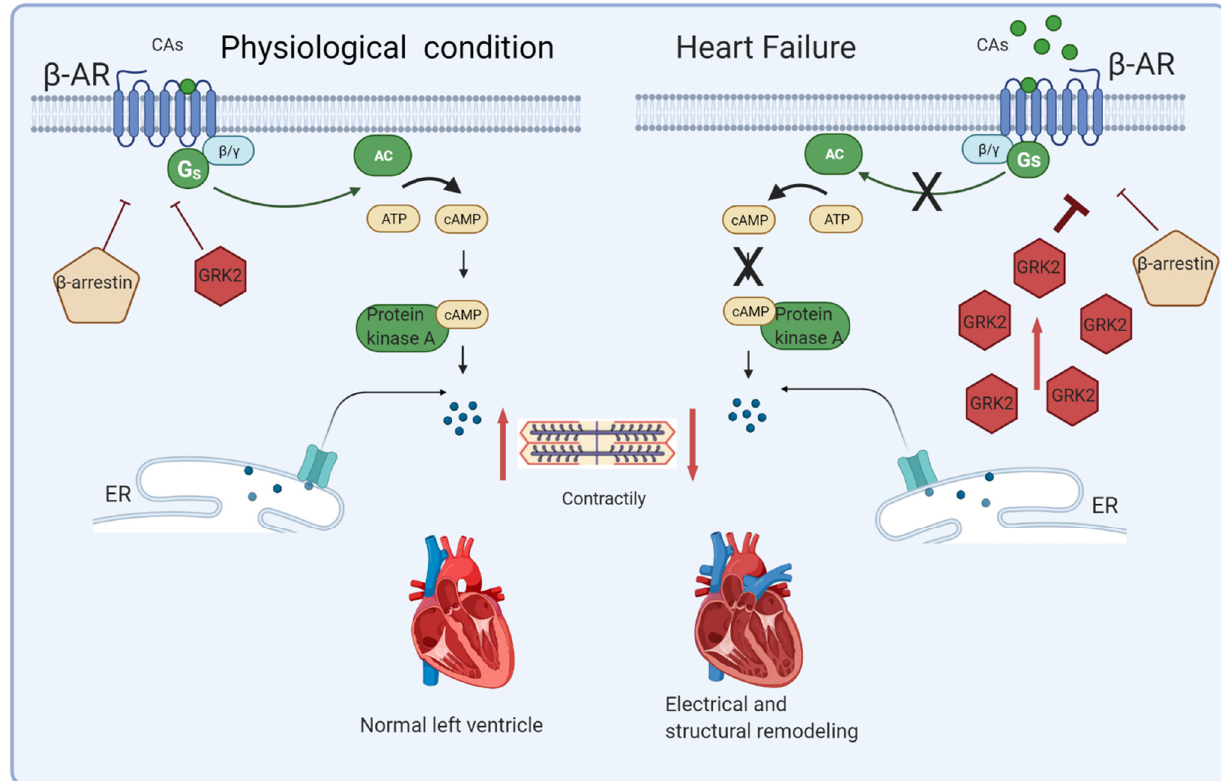
Figure 1. Graphical representation of β -AR signaling in the physiological condition (left) and heart failure (right). In the physiological condition (left panel), β -AR stimulation by CA results in the dissociation of the stimulatory G-protein α -subunit (G α s) from G βγ . G α s stimulates adenylate cyclase (AC) to produce cAMP, which leads to increased contractility by activating the protein kinase A (PKA). The G protein-coupled receptor kinase (GRK2) translocates to the membrane and phosphorylate agonist-bound β -AR, leading to the decoupling of the G protein. Finally, β -arrestins bind the complex, triggering receptor internalization and downregulation. In heart failure (right panel), the increase in CA levels determines the β -AR hyperactivation and consequent GRK2 upregulation, which, in the long term, results in β -AR dysfunction. (AC, adenylate cyclase, ATP, adenosine triphosphate, CAs, catecholamines, β -Ars, β -adrenergic receptors, cAMP, cyclic adenosine monophosphate, ER, endoplasmic reticulum, GRK2, G protein-coupled receptor kinase 2, and Gs, stimulatory G protein). Created with BioRender.com .